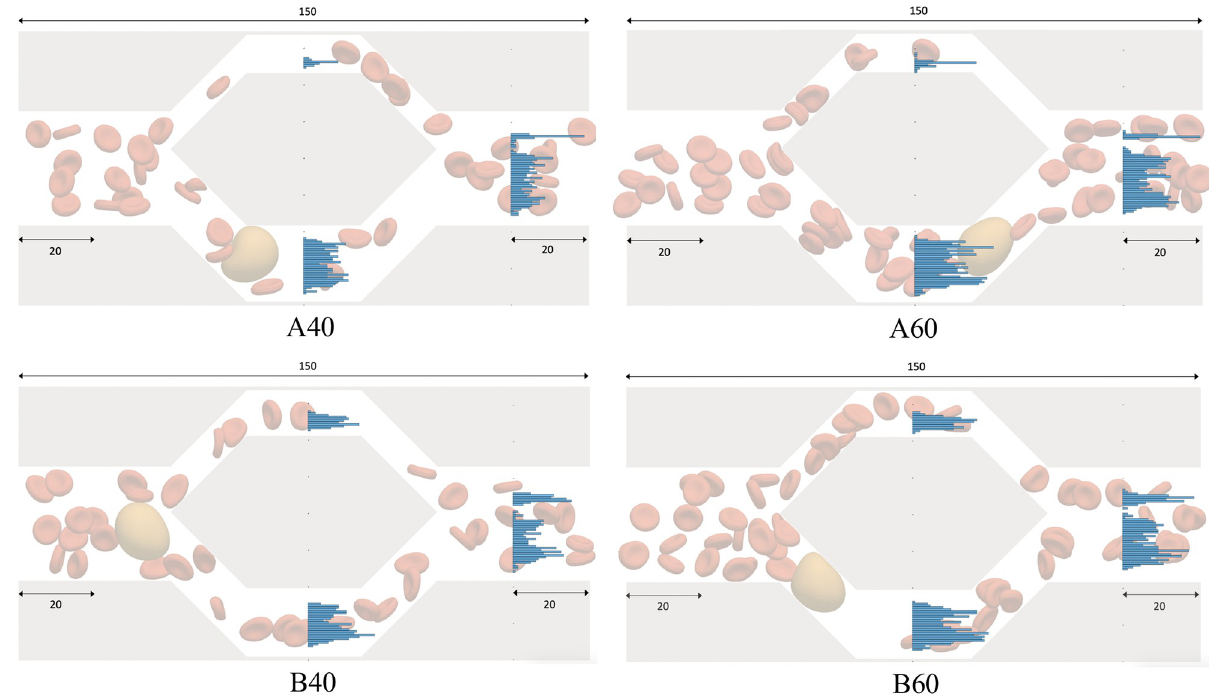
Fig 2. Distribution of red blood cells in daughter branches and after the confluence. The histograms indicate y -coordinates of RBC centers as the cells crossed the x = 75 μm and x = 130 μm positions. The ratio of sizes of daughter branches is 1:2 in case A and 2:3 in case B. In the two cases on the left, there were 40 red blood cells ( Ht � 4%) and in the two cases on the right, there were 60 red blood cells ( Ht � 6%). The indicated dimensions are in micrometers. The height of the channel was h = 20 μm .